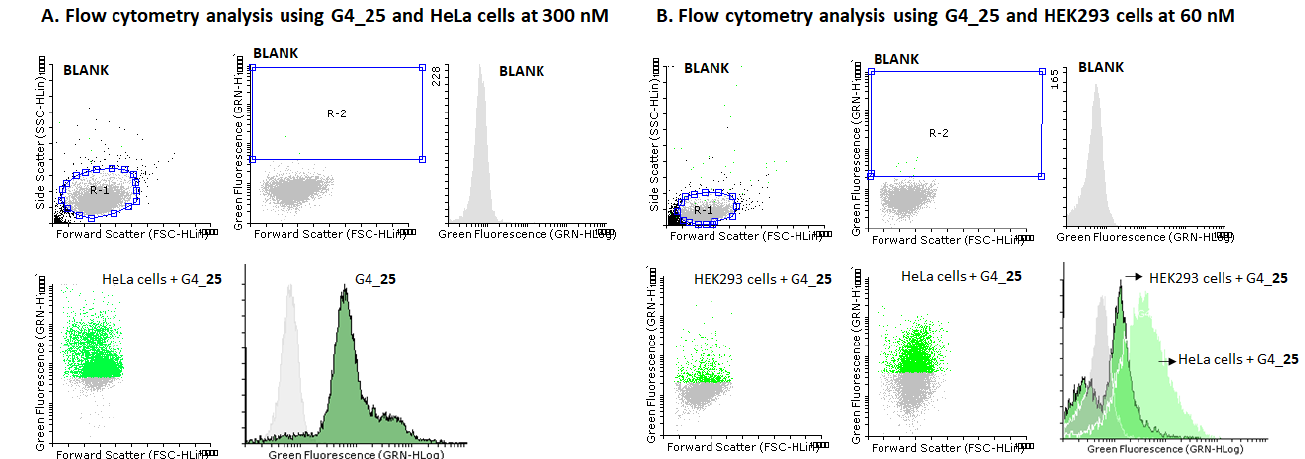
Figure 9. Flow cytometry analysis involving the effect of the G-rich sequence 25 when transfecting HeLa ( A ) and HEK293 cells ( B ). ( A ) Transfections were carried using G-rich sequence 25 at 300 nM. First row: non-fluorescent labelled cell populations (Blank); selected region R-2 (center) and histogram of non-fluorescent cells (right); second row: forward scatter dot plot (left) and histogram (right) of G-rich sequence 25 in the presence of HeLa cells at 300 nM. ( B ) Transfections were carried using G-rich sequence 25 at 60 nM. First row: non-fluorescent labelled cell populations (Blank); selected region R-2 (center) and histogram of non-fluorescent cells (right); second row: forward scatter dot plot (left) using G-rich sequence 25 and HEK293 cells; forward scatter dot plot (middle) using G-rich sequence 25 and HeLa cells and combined histogram (right) of G-rich sequence 25 in the presence of HeLa and HEK293 cells at 60 nM. The Flowing Software 2.5.1 was used to measure the relationship between untreated cells and positive cell populations.